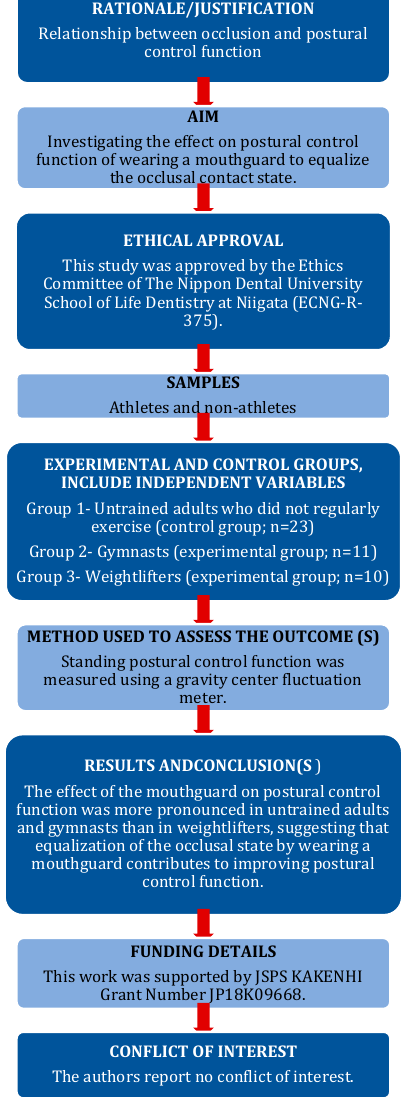
Figure 1. PRILE Flowchart.